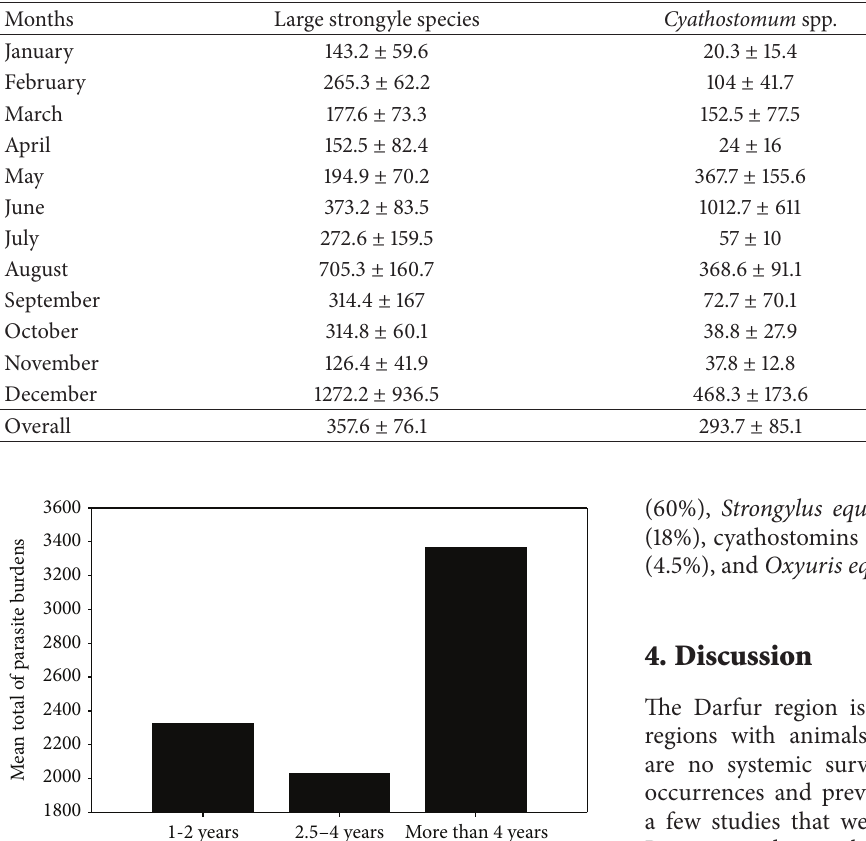
Table 4: Monthly mean worm count ± SEM of parasites recovered from caecum of necropsied donkeys. Cyathostomum spp.